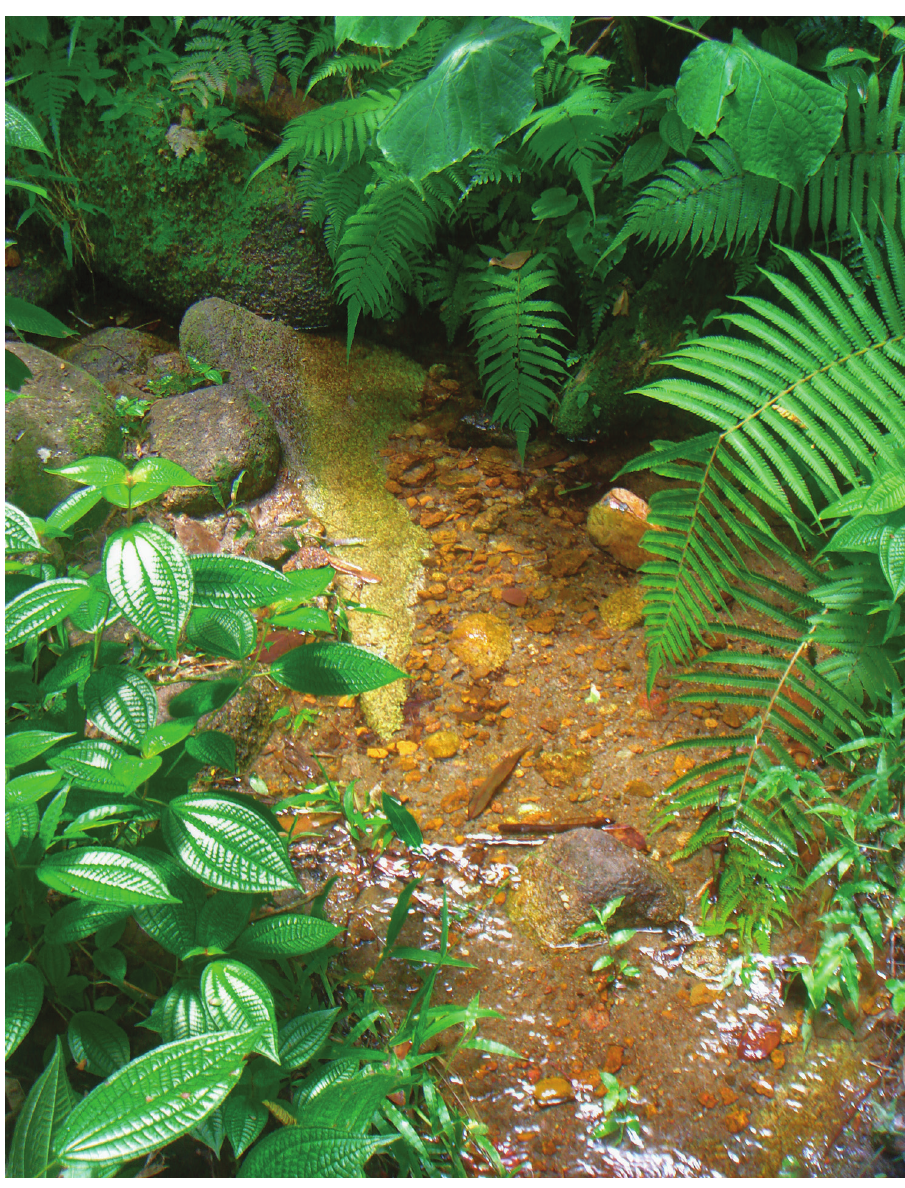
Figure 21. Habitat of Hydraena matyoti Jäch & Delgado, sp. n. Small stream, Morne Seychellois Na- tional Park,